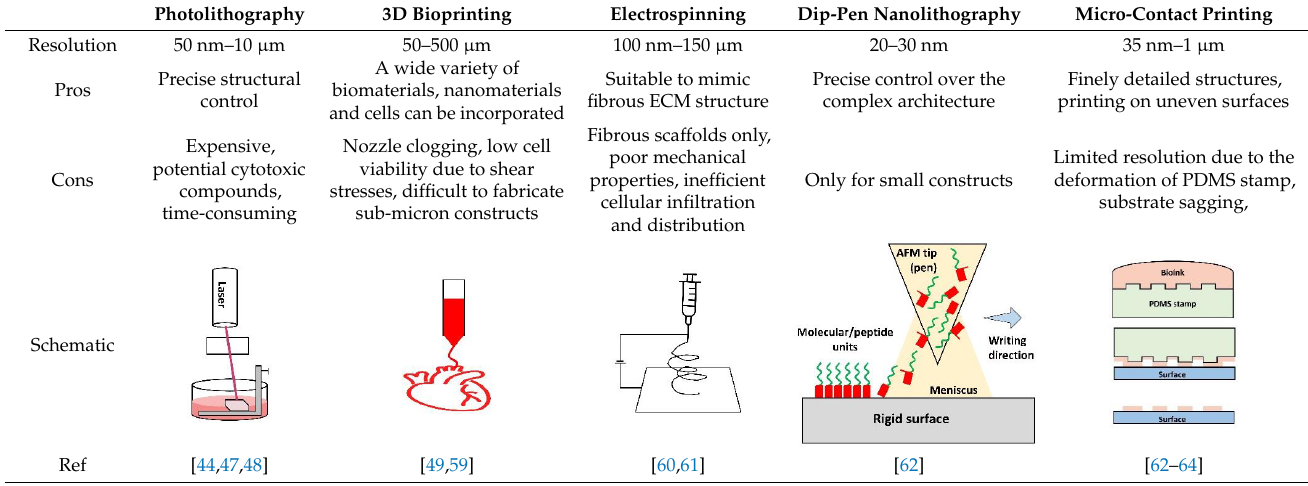
Table 1. Techniques to fabricate micro/nano-structured constructs.